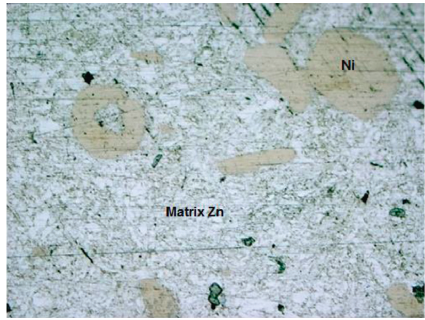
Figure 8: Typical microstructure of green compact powder ob- tained by optical microscopy at 20x of the Zn-Ni 5 alloy prepared by high-energy mechanical milling without